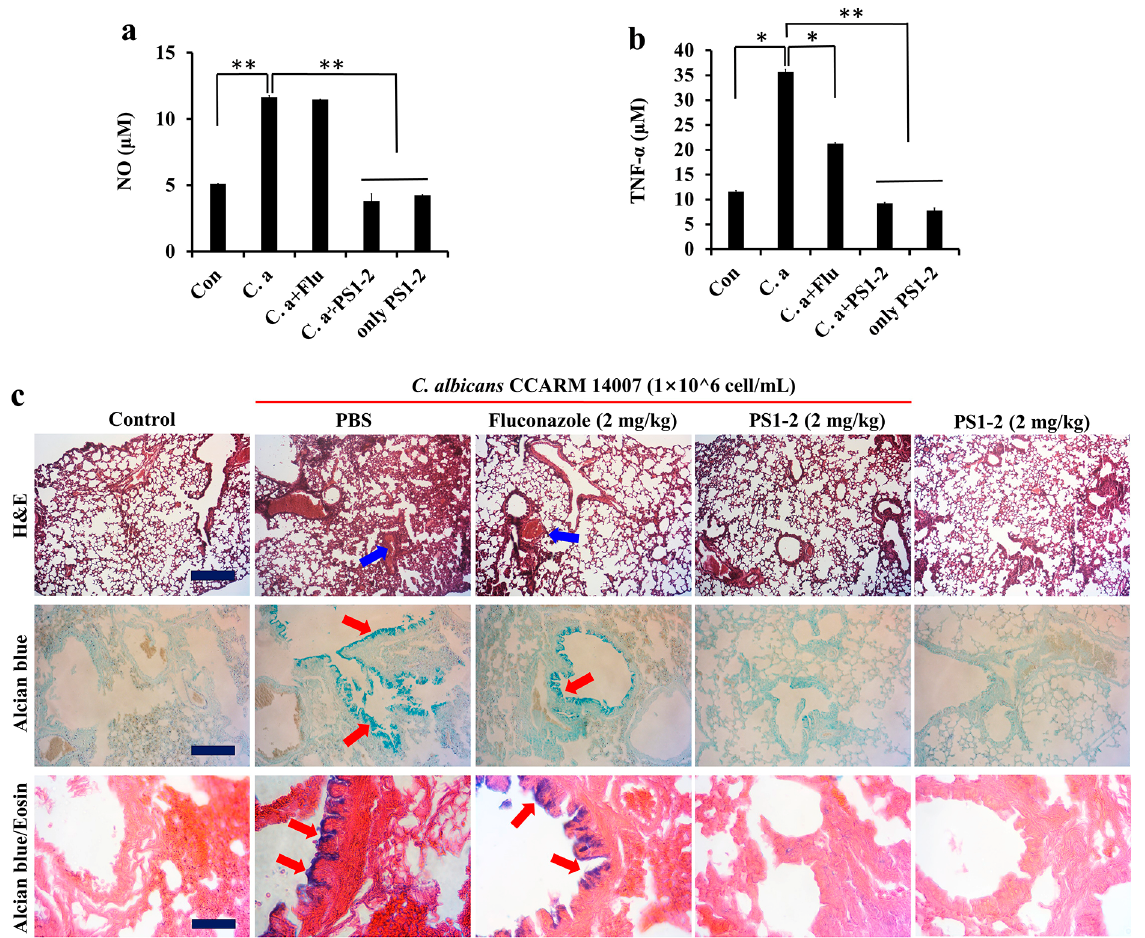
Figure 6. In vivo anti-inflammatory effects of peptides in lung injury. C. albicans CCARM 14007 (1 × 10 5 cells) was intratracheally instilled in mice lung. One hour after instillation, peptides were intratracheally subjected, followed by monitoring for 6 days. Measurement of NO production ( a ) and TNF- α secretion ( b ) levels with whole blood serum in the presence or absence of fluconazole and PS1-2 at the indicated doses (* p < 0.05, ** p < 0.01). ( c ) Hematoxylin and eosin (H&E), alcian blue, and alcian blue and eosin staining showing induced inflammation on the lung tissues. Red arrows: an increase in the release of mucins, blue arrows: inflammatory cell infiltrates around the bronchus and alveoli. Size bar = 2 mm.